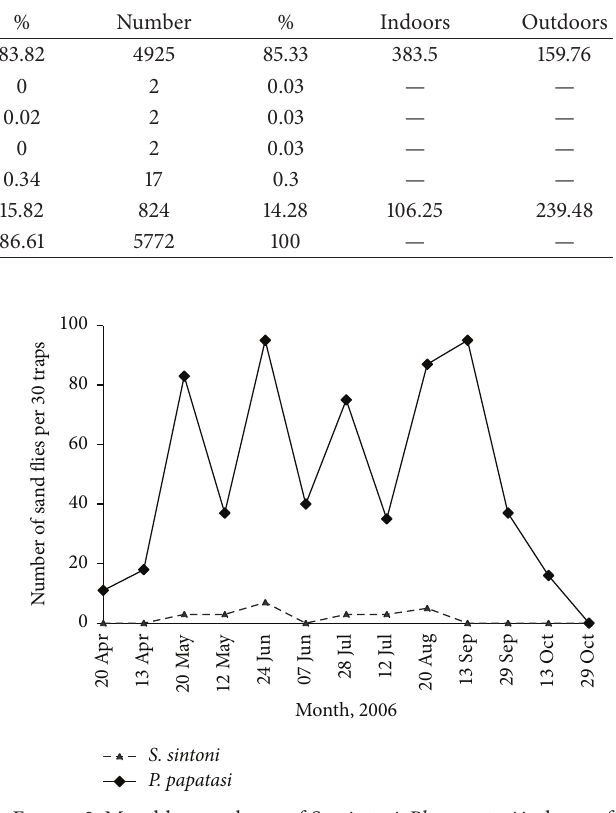
Figure 2: Monthly prevalence of Se. sintoni, Ph. papatasi indoors of Khatam County, Yazd Province, central Iran,